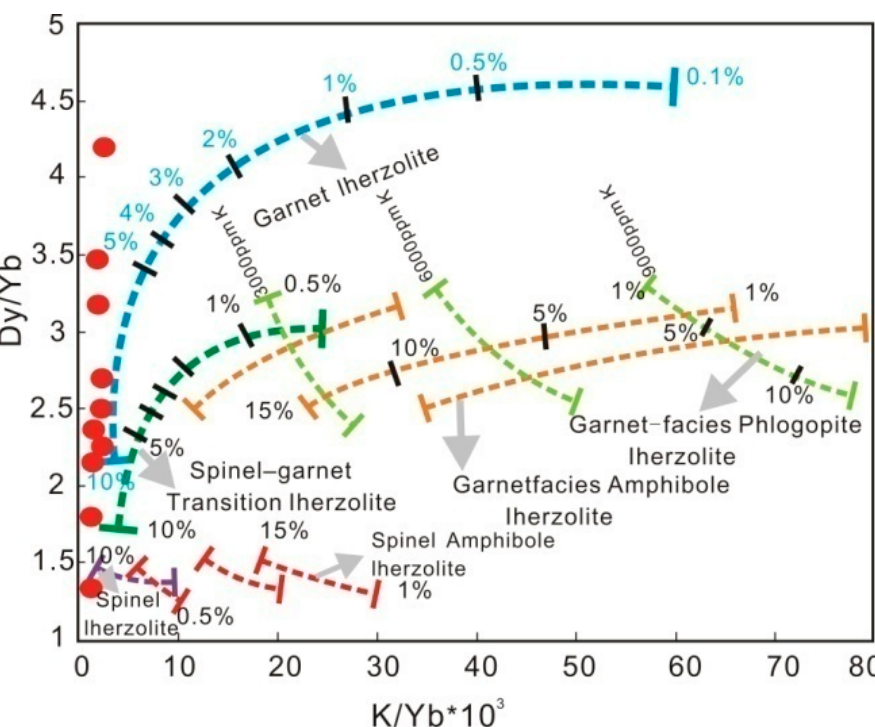
Figure 13. K/Yb vs. Dy/Yb diagram for BAS. The samples plot suggested that garnet was a residual phase in the source(s) of the BAS. Percentages indicate degrees of partial melting (base drawing from [52].